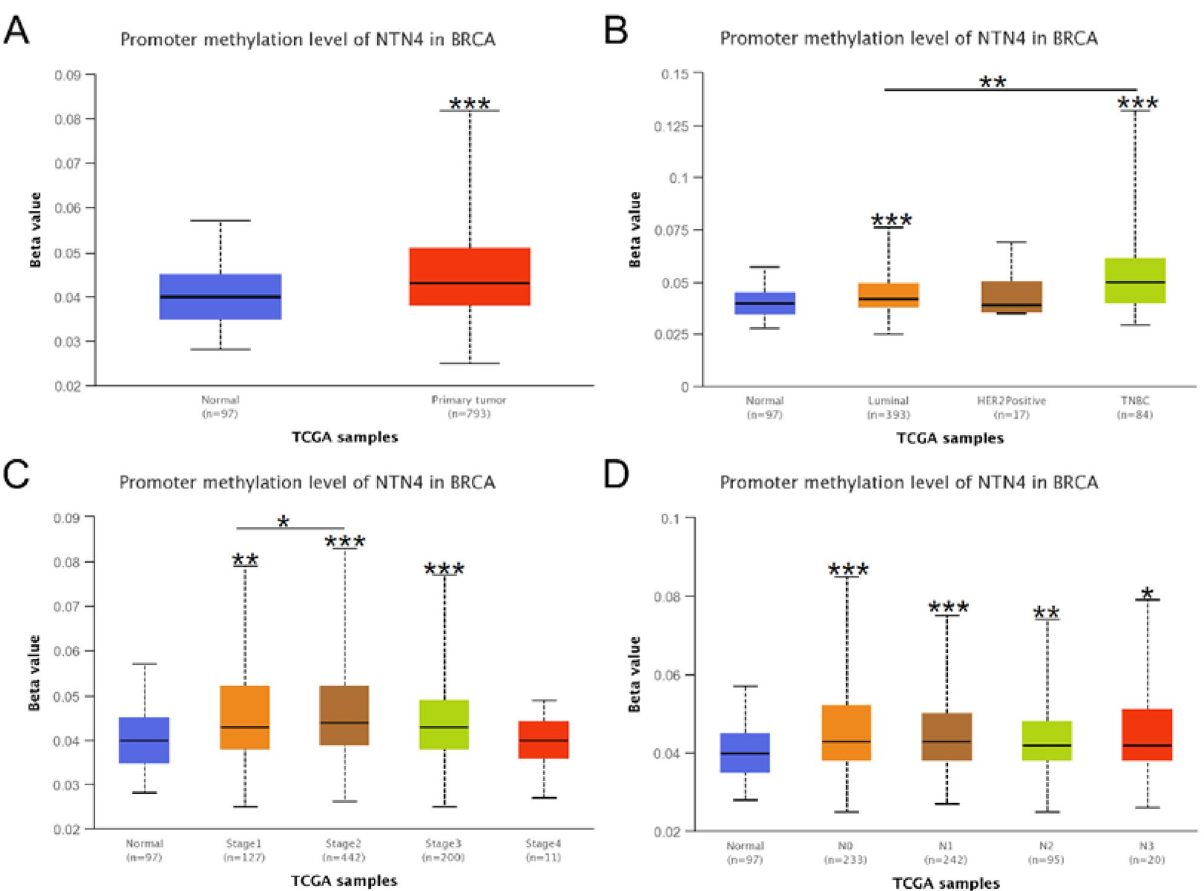
Figure 3. UALCAN analysis of NTN4 promoter methylation in breast cancer. NTN4 promoter methylation levels in breast cancer were compared based on different ( A ) sample types, ( B ) molecular subtypes (TNBC), ( C ) individual cancer stages, ( D ) lymph nodal status.